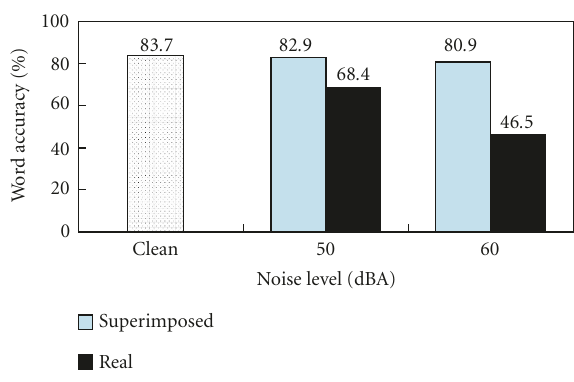
Figure 8: Nonaudible murmur recognition using noisy test data (o ffi ce noise).